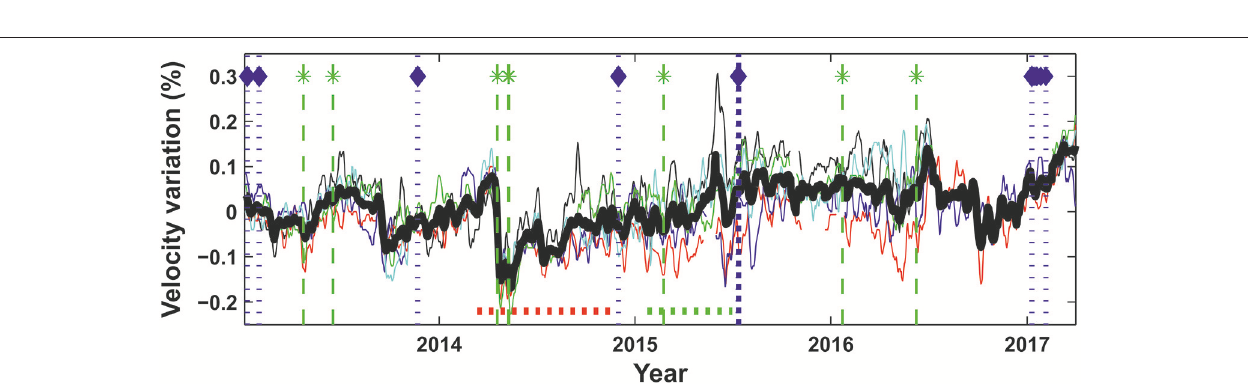
FIGURE 1 | Map of the monitoring seismic network of Volcán de Colima (VC). EZV3-6 are short-period stations. Yellow lines indicates the pairs of broadband stations used to calculate the velocity variations. The red frame delineates the area displayed on the images of Figure 4 .